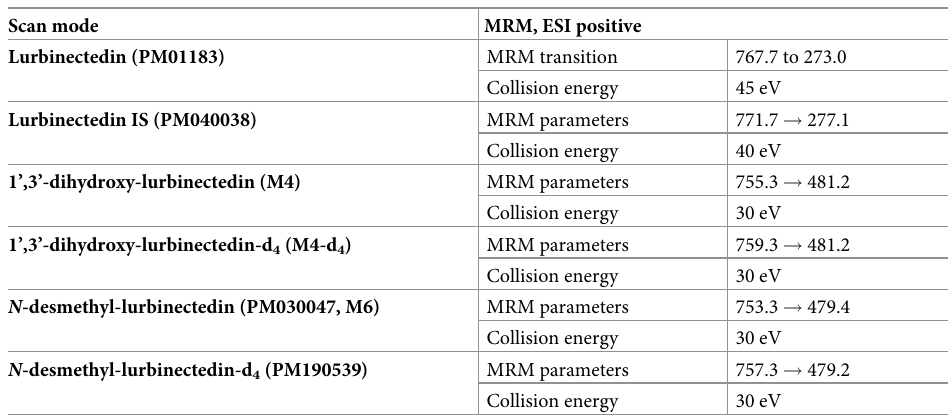
Table 1. MS detector parameters. Scan